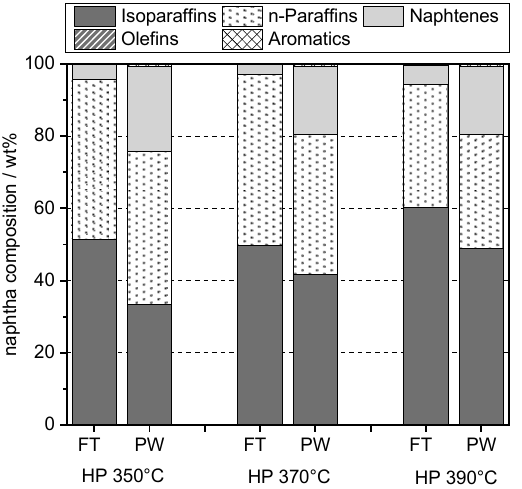
Figure 14. Comparison of naphtha compositions after HP of FTW and PW.